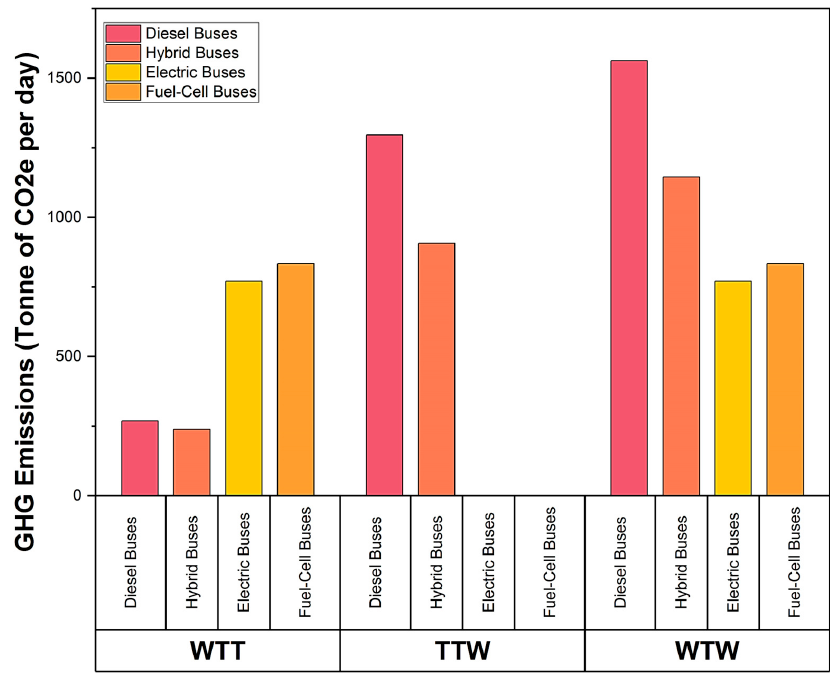
Figure 8. Daily GHG Emissions of Different Fuel Bus Technologies in Morocco.